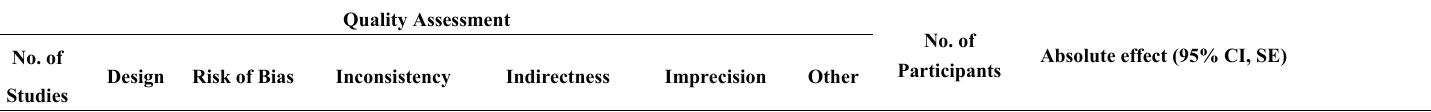
Table 6. Associations between outdoor time and blood